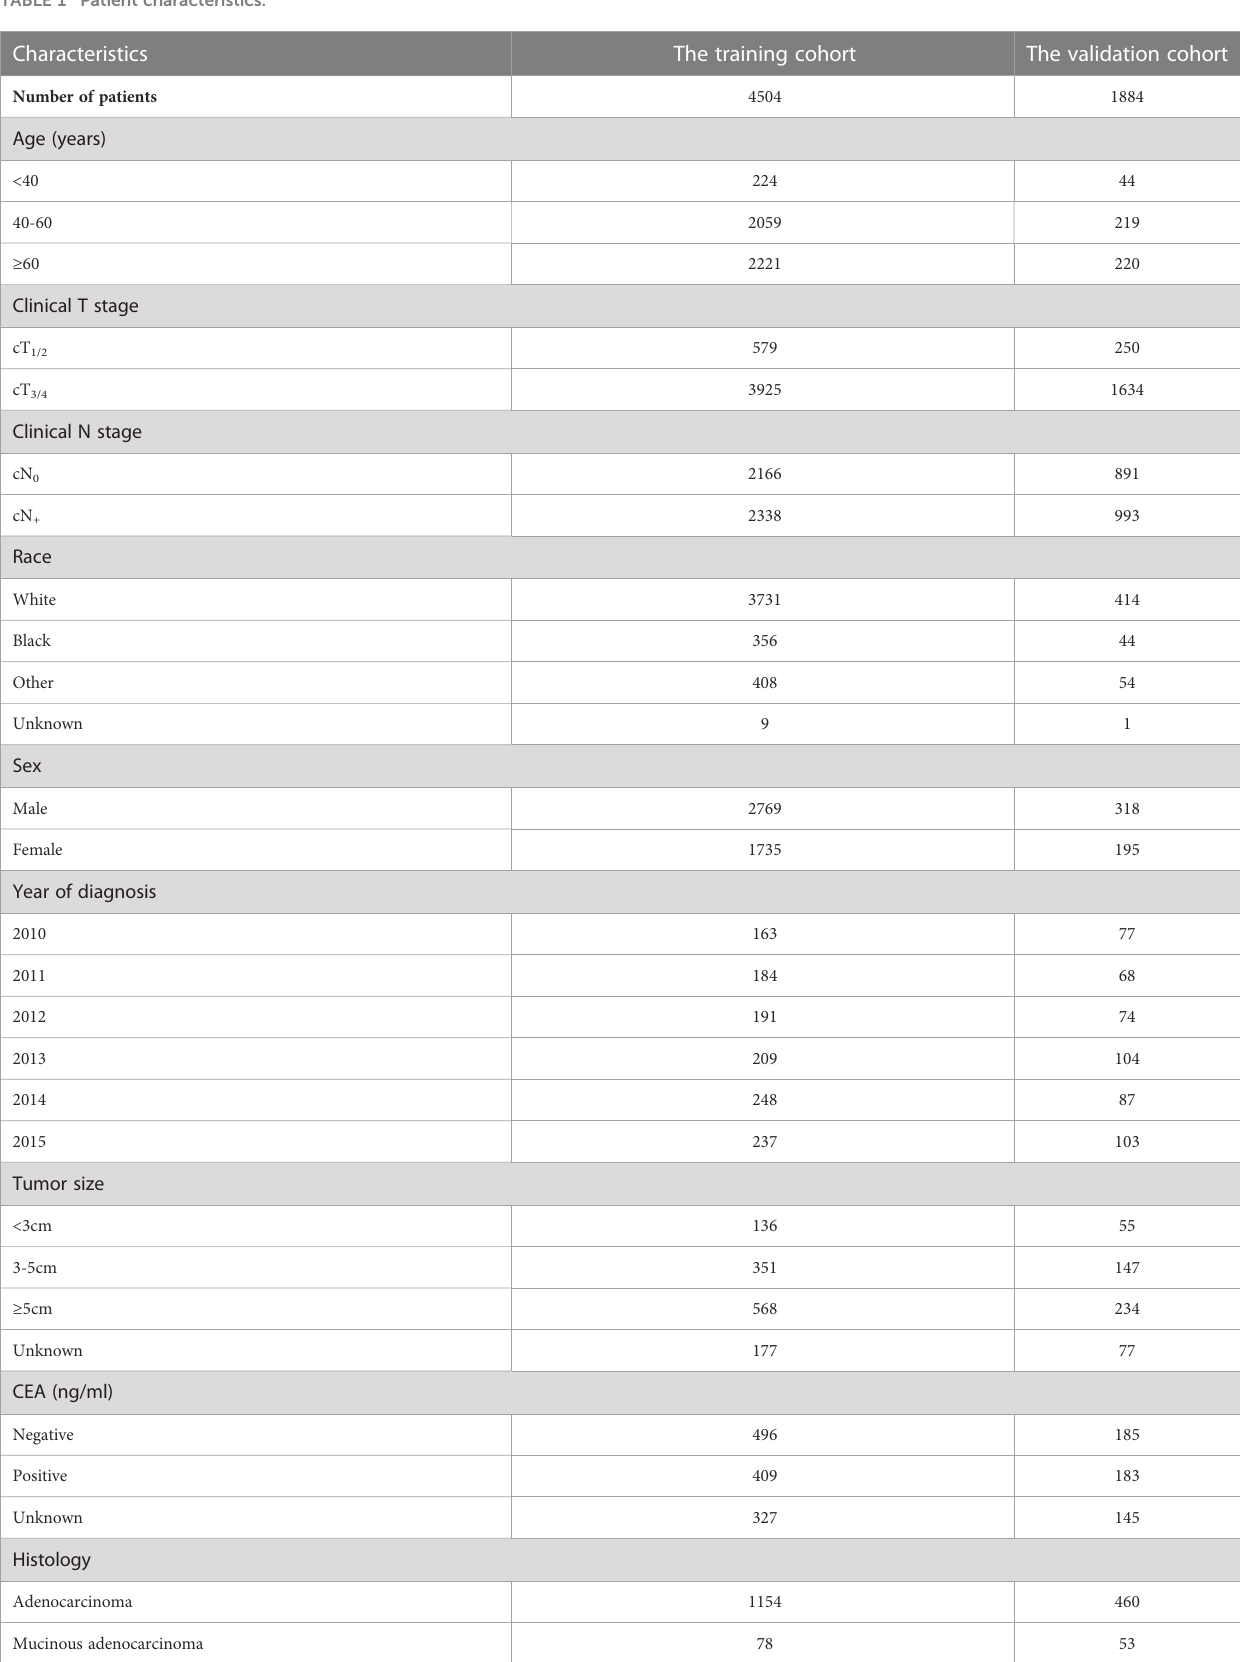
TABLE 1 Patient